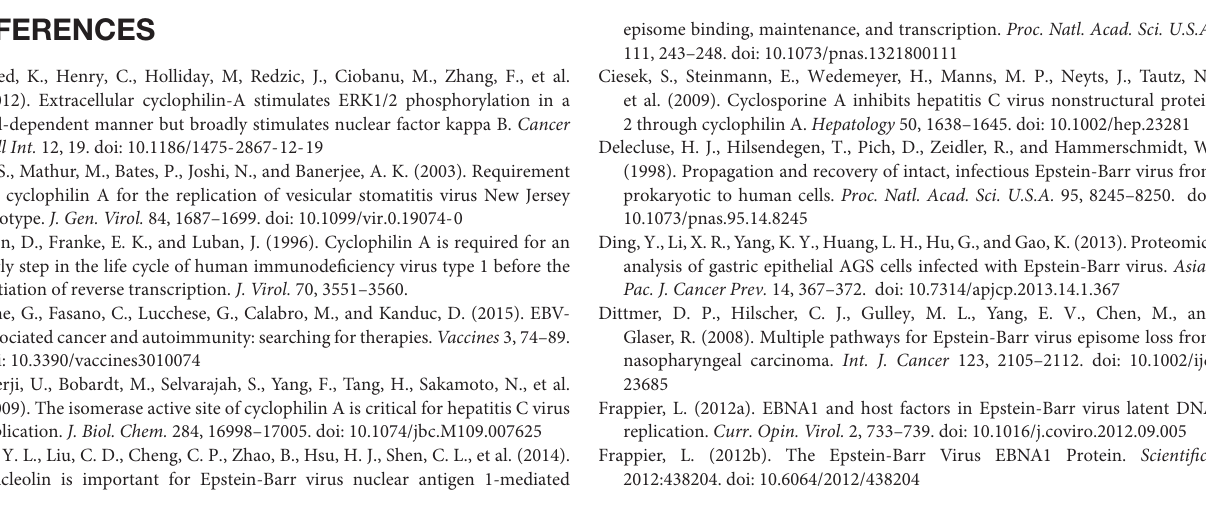
FIGURE S1 | The schematic diagram of the BiMC assay. FIGURE S2 | CYPA expression was detected by IF assay in Vero and HEK293T cells. Scale bar, 100 µ m. After transfected the pCAGGS-Flag-CYPA plasmid for 24 h in Vero cells, the Flag antibody was incubated overnight in 4 ◦ C, followed by green fluorescent secondary antibody in 37 ◦ C for 1 h, hoechst33342 stained nucleus. HEK293T cells, CYPA antibody incubated overnight, followed by red fluorescent secondary antibody, stained nucleus. FIGURE S3 | Detection of EBNA1 mutants and CYPA using BiMC assays. (A) Detection of the interaction between each mutant and CYPA by BiMC assay. Scale bar, 50 µ m. (B) Verification of the interaction between the single EBNA1 domain containing aa 376-459 and CYPA by the BiMC assay. Scale bars, 50 µ m. (C) Negative controls for each single plasmid in BiMC assay. TABLE S1 | Primer sequences used in the